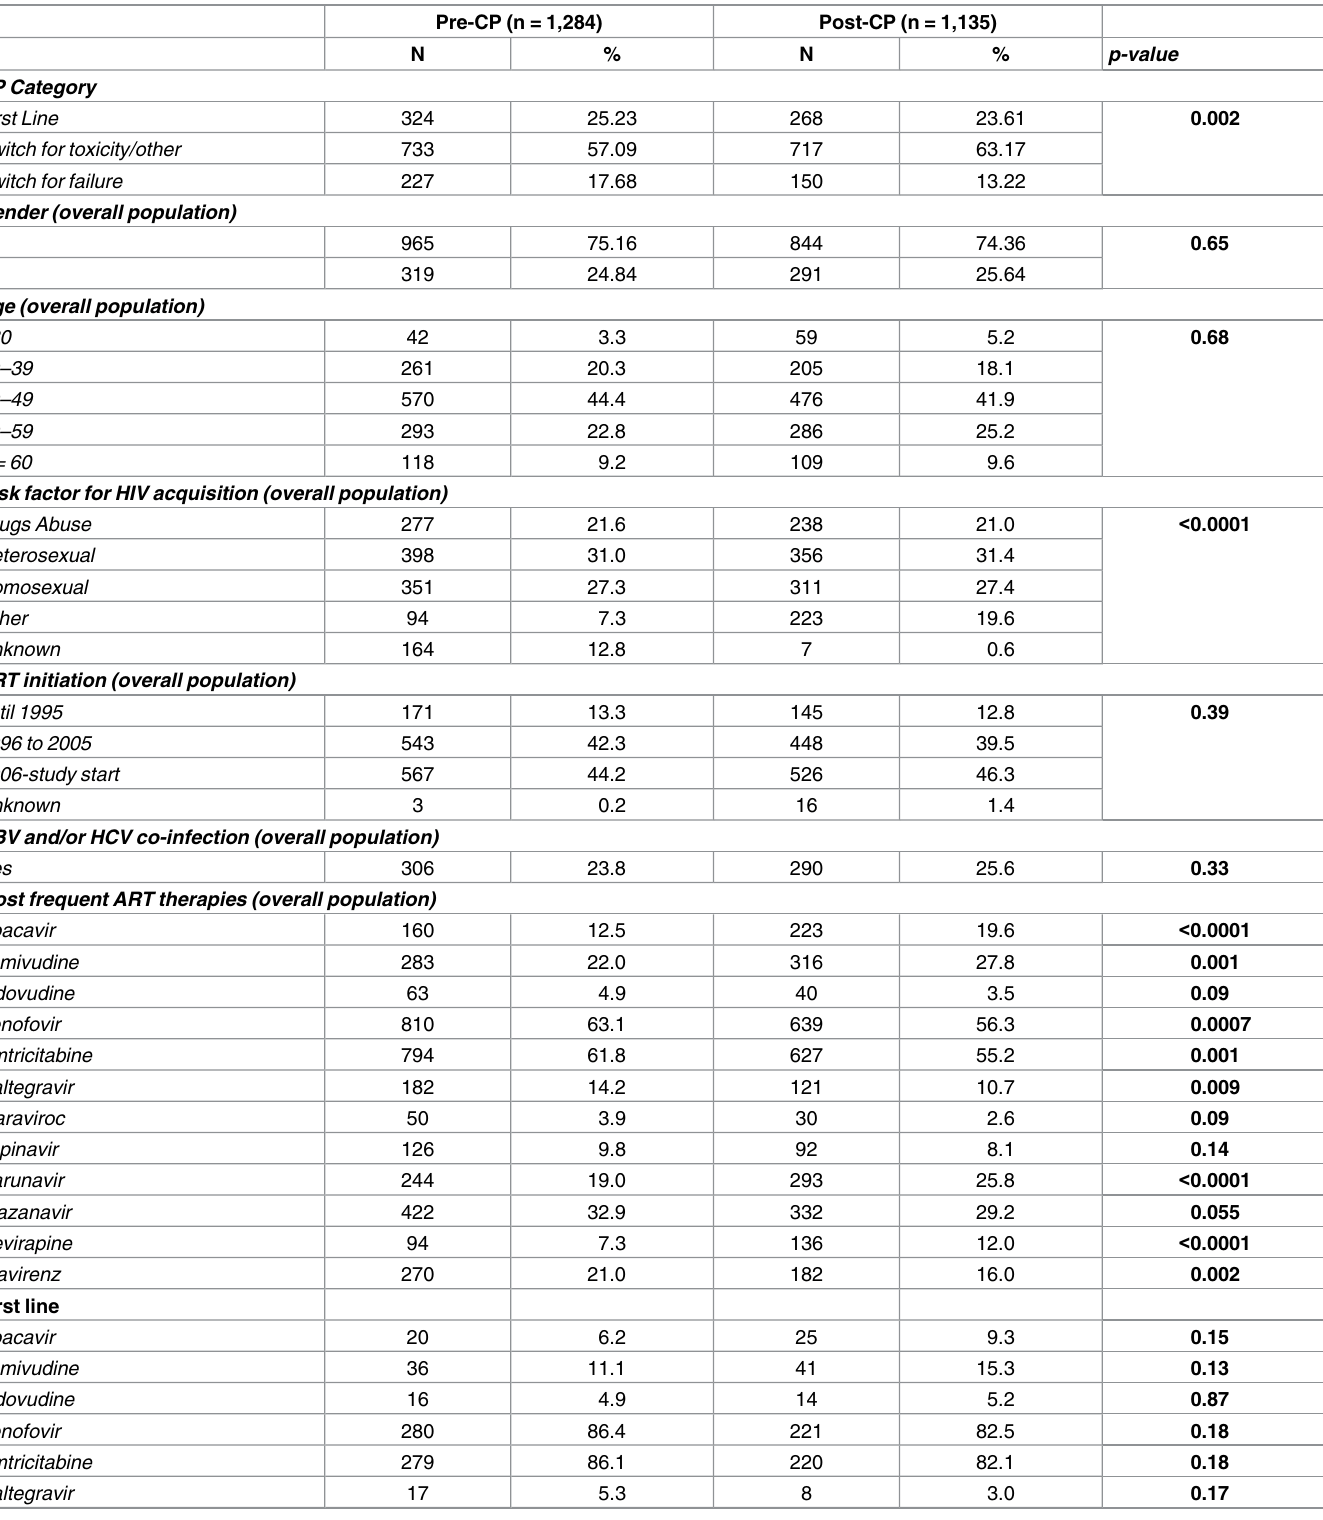
Table 1. Patients’ baseline characteristics, Lombardy Region, Italy, comparing Pre-CP (2009–2010) and Post-CP